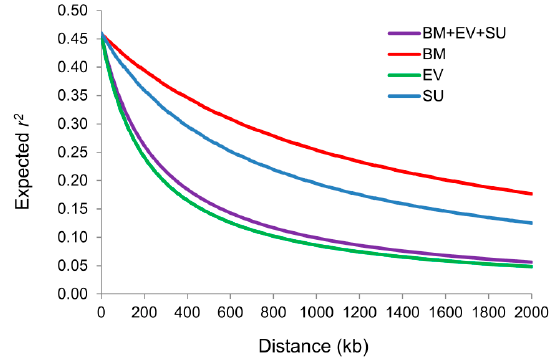
Figure 2. Intra-chromosome LD ( r 2 ) decay of SNP pairs over the entire flax genome as a function of physical distances (kb) of pair-wise SNPs for the three individual and merged populations. The curves are drawn based on a fitted non-linear model (see Section 4.2).